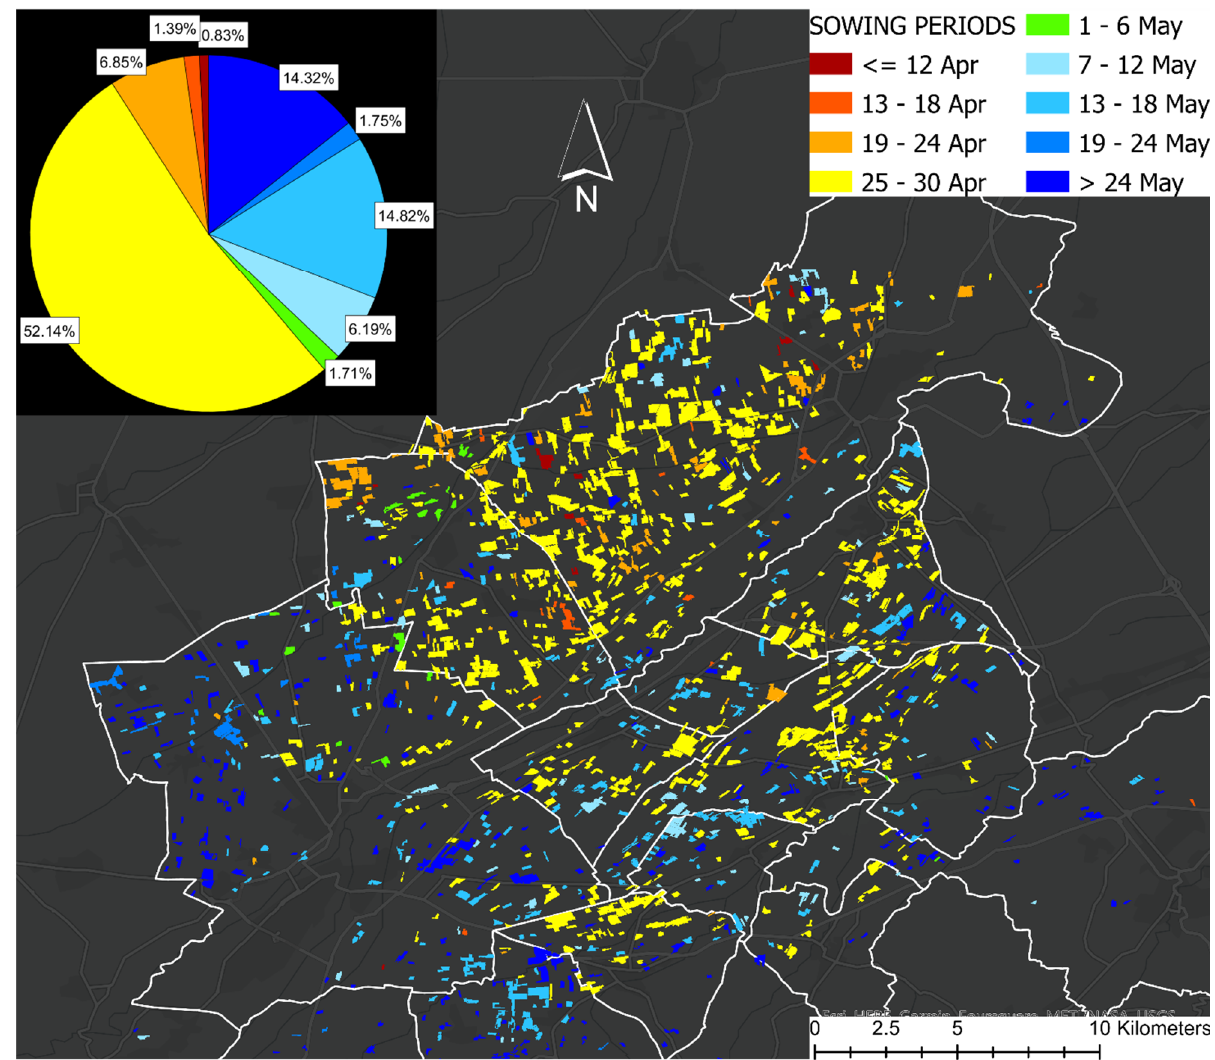
Figure 7. Spatial distribution of sowing dates at 10 m × 10 m resolution. The sowing periods are grouped by 6 – days classes. The spatial variability confirms the SAR analysis of emergence periods: for lower elevations, maize is sowed earlier on average.